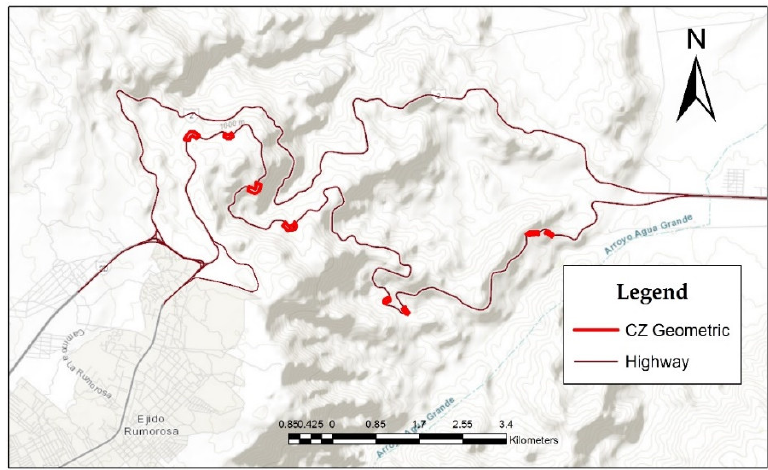
Figure 6. Geometric condition in mountain zone.